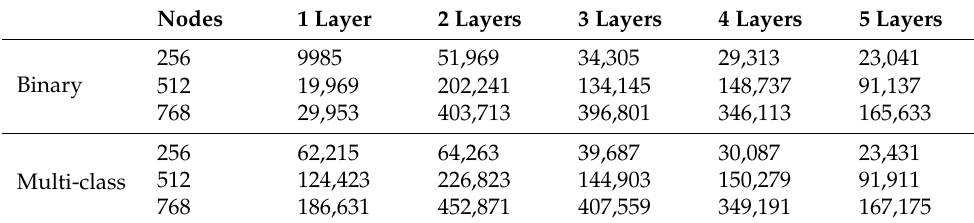
Table 10. The number of parameters of the CNN model. Nodes 1 Layer 2 Layers 3 Layers 4 Layers 5 Layers